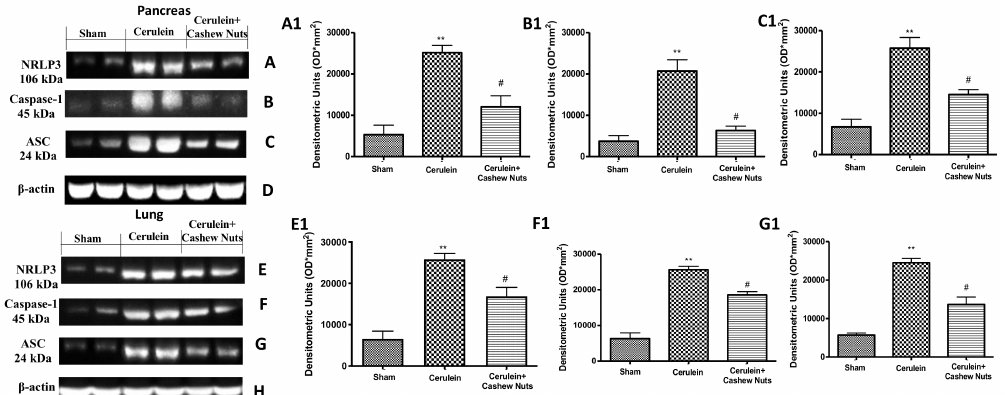
Figure 6. E ff ects of cashew nuts on the NLRP3 pathway in cerulein-induced AP as assessed by Western blotting. Pancreatic Western blots of NLRP3 ( A ), Caspase-1 ( B ), ASC ( C ) and β -actin ( D ). Relative densitometric quantification for pancreatic NLRP3 (A1), Caspase-1 (B1) and ASC (C1). Lung Western blots of NLRP3 ( E ), Caspase-1 ( F ), ASC ( G ) and β -actin ( H ). Relative densitometric analysis of lung NLRP3 (E1), Caspase-1 (F1) and ASC (G1). Values shown are means ± SEM of 6 mice. # p < 0.05 vs. cerulein; ** p < 0.01 vs.